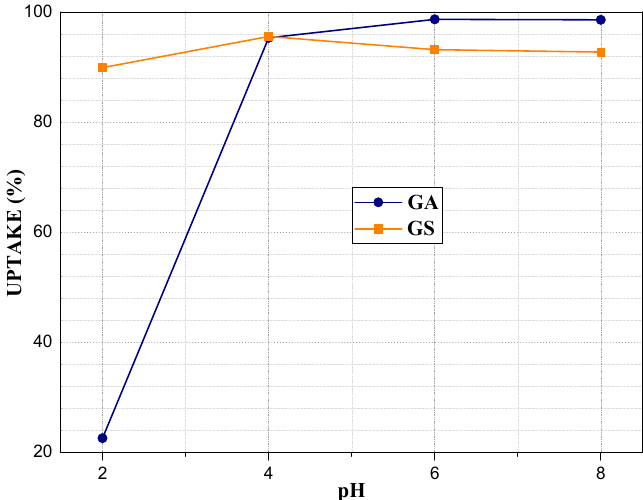
Figure 9. Influence of pH on geopolymers adsorption capacity of Pb 2+ : m = 0.15g, V = 40mL, C 0 = 5 mg/L.